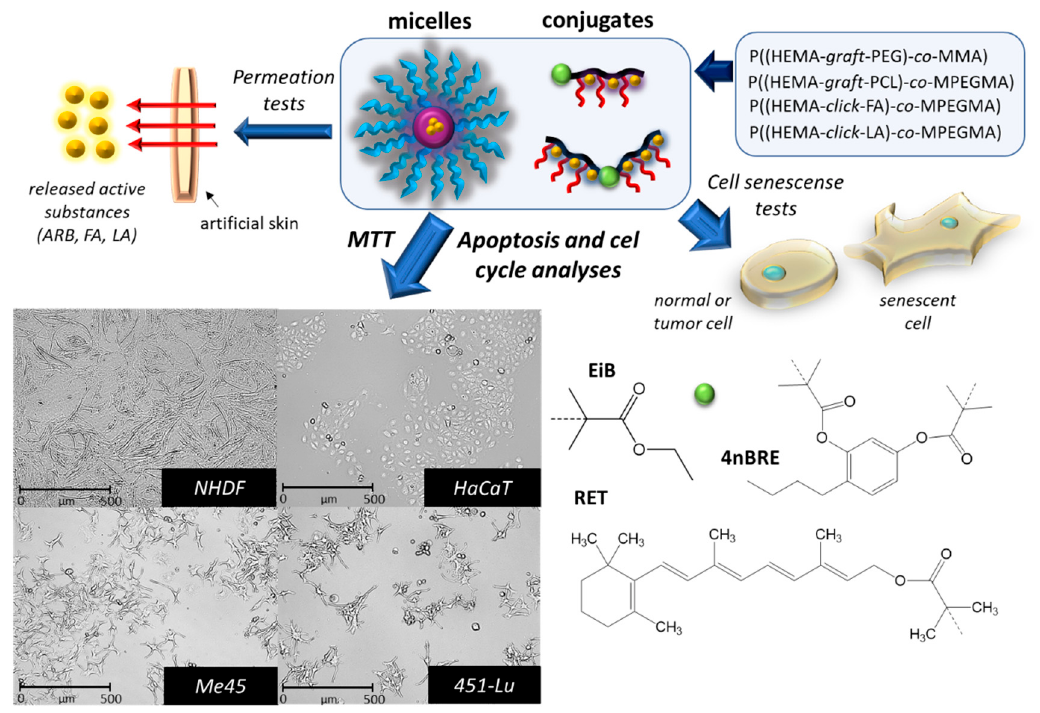
Figure 2. Preliminary biological evaluation of the potential for using carriers in cosmetic products.